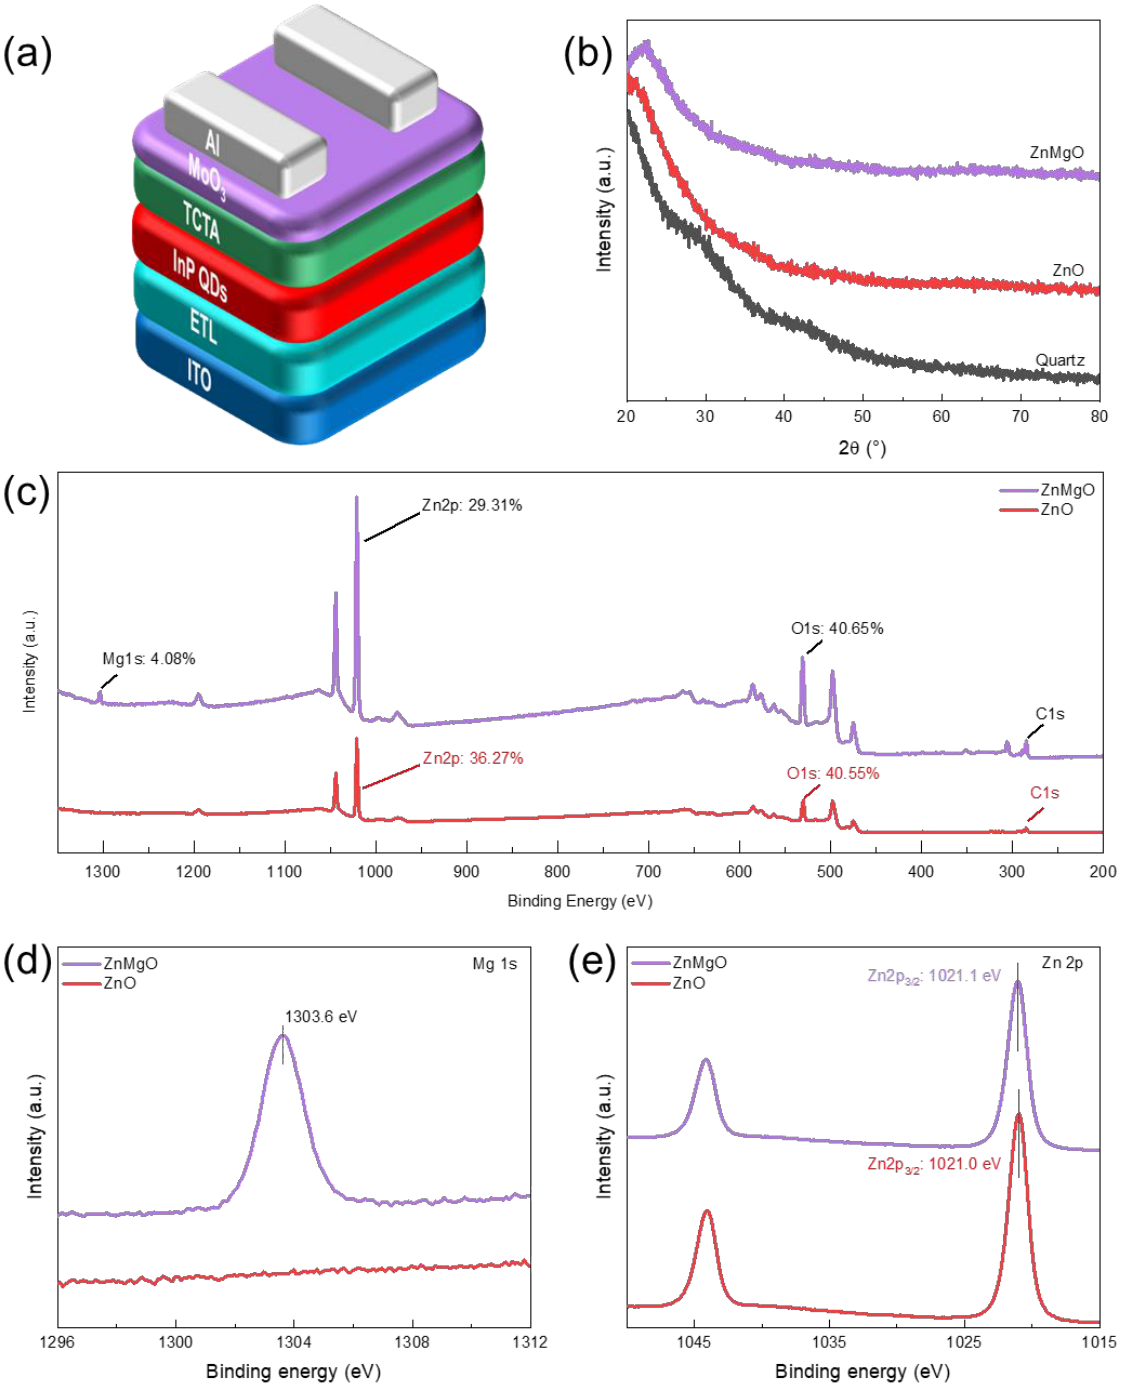
Figure 1. ( a ) Schematic diagram showing the structure of the device; ( b ) XRD patterns of the ZnO and ZnMgO films; ( c ) full spectra of XPS, and the ratios of Mg, Zn, and O elements were calculated using the peak areas; ( d ) fine XPS spectra of Mg element; and ( e ) fine XPS spectra of Zn.